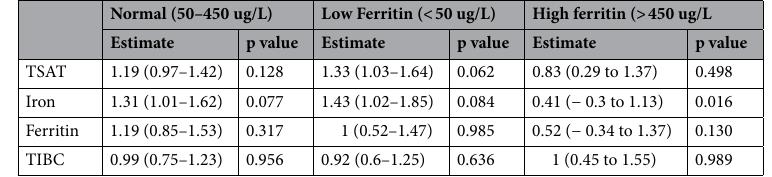
Table 4. Odds ratios for a one SD increase in each PRS in each stratum of ferritin